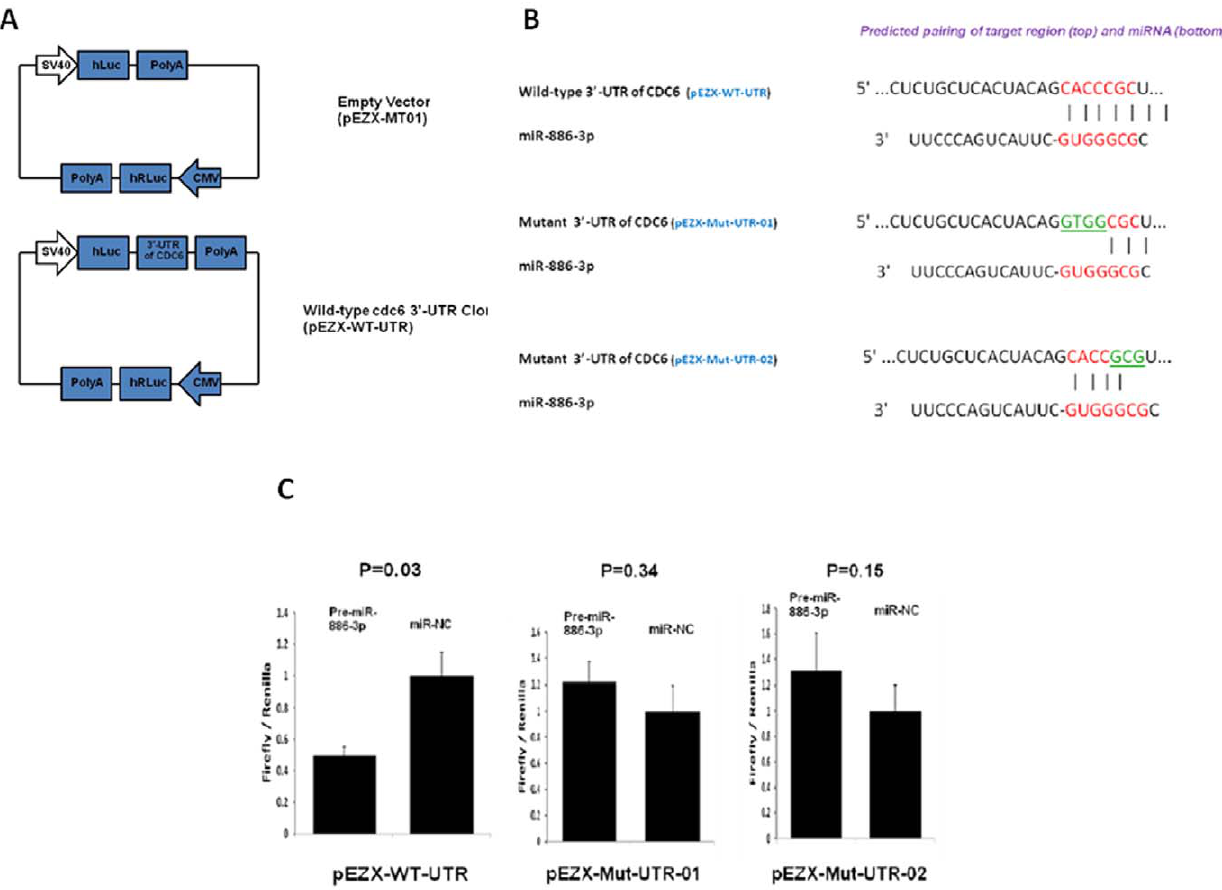
Figure 6. Analysis of miR-886-3p effect on 3 9 -UTR of CDC6 . A ) pEZX-WT-UTR vector with both Renilla luciferase (hRLuc) was used as an internal control and firefly luciferase (hLuc) was upstream of the 3 9 -UTR construct. B ) Putative binding site of miR-886-3p on the CDC6 3 9 UTR along with the mutations in the predicted seed region. C ) Left figure shows luciferase activity of pEZX-WT-UTR in TPC-1 cells when co-transfected with pre-miR-886-3p or pre-miR-NC, p , 0.05. Middle and right figures showluciferase activity of pEZX-Mut-UTR-01and pEZX-Mut-UTR-02 inTPC-1cells whenco-transfectedwith pre- miR-886-3p or pre-miR-NC, respectively. All luciferase measurements were made in triplicates and readings were performed at 24 hours post-transfection. doi:10.1371/journal.pone.0024717.g006 PLoS ONE |